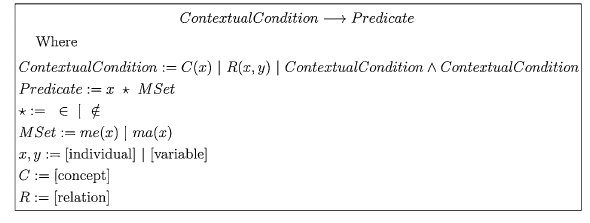
Algorithm 1: General format of high-level security policy [16]